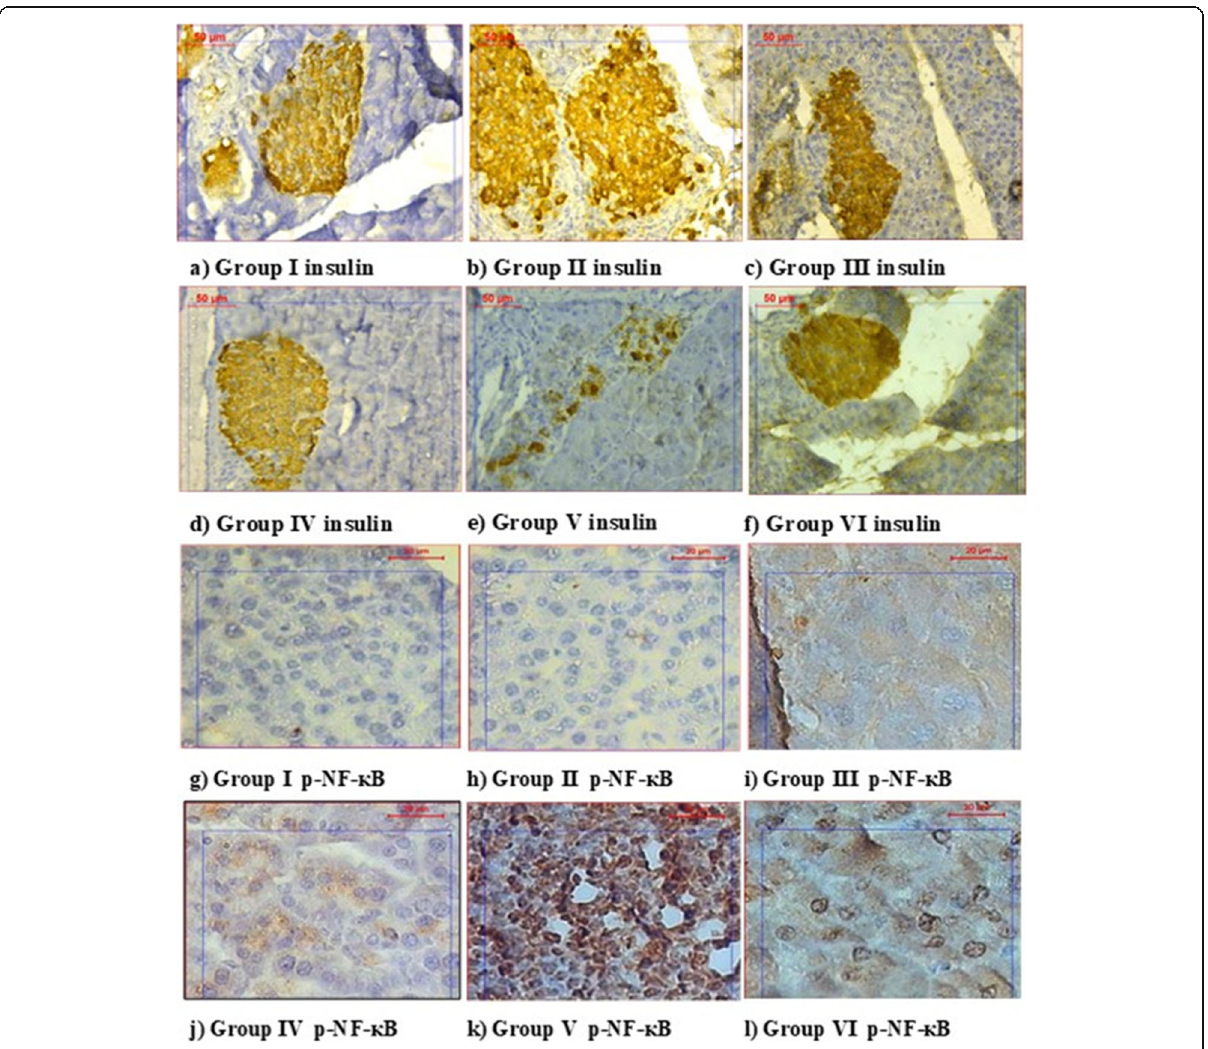
Fig. 2 Expression of insulin and phosphorylated-NF- κ B by immunohistochemistry. Photomicrographs of pancreatic islets stained with positive brown color for anti-insulin ( a – f ) and anti-p-NF- κ B antibodies ( g – l ) in CD1 mice. Group I, normal mice; group II, mice treated with citrate; group III, mice treated with DMSO; group IV, mice treated with curcumin at a dose of 170 mg/kg; group V, diabetic mice induced by injection with 160 mg/kg of STZ; group VI, diabetic mice treated with curcumin with a dose of 170 mg/kg. Magnification is × 400. p-NF- κ B, phosphorylated-NF- κ